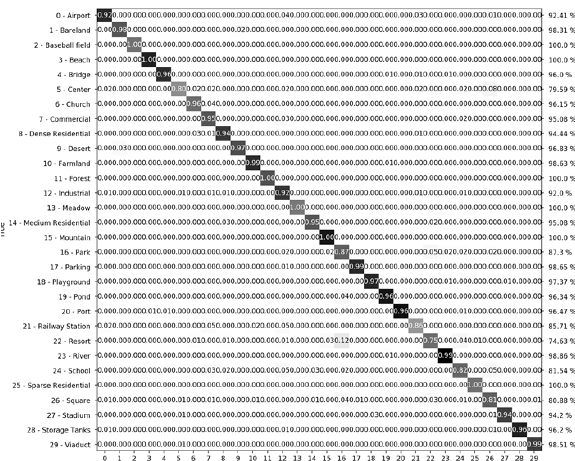
Figure 9. AID Dataset Confusion Graph of SE-Inception